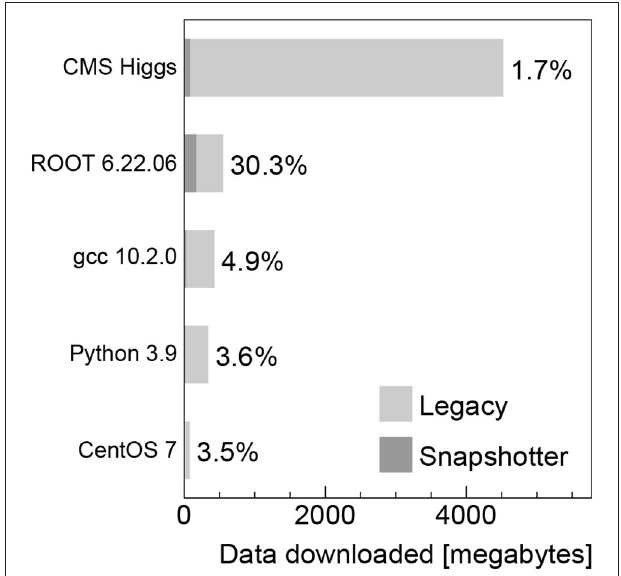
FIGURE 4 | Data downloaded from the container registry and CVMFS for the legacy and snapshotter machines, respectively, in megabytes for the container images analyzed. The percentages indicate the fraction of data downloaded when using the CVMFS snapshotter compared to the full compressed image in the